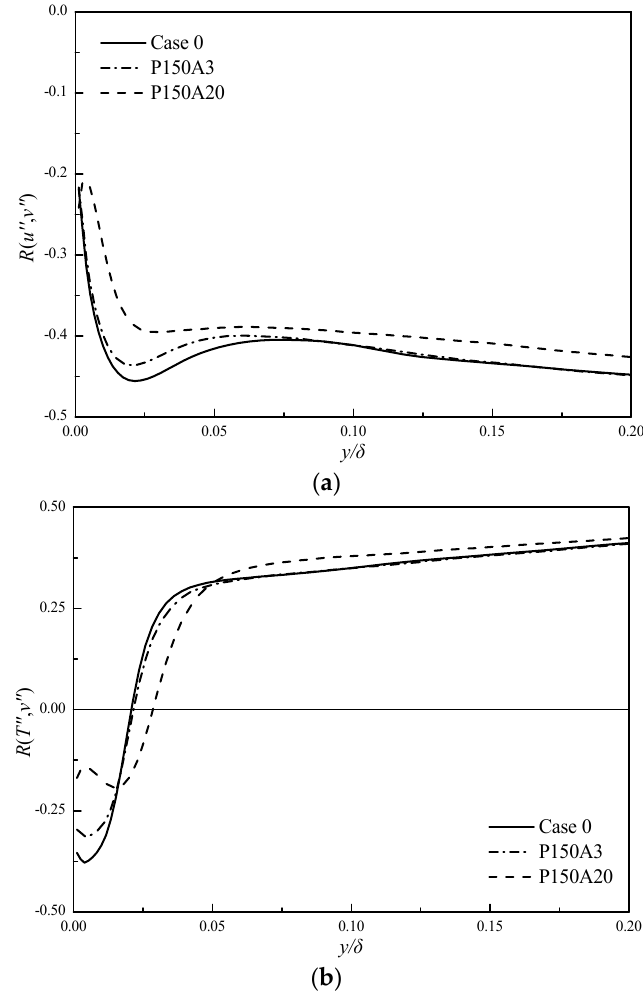
` ˘ u 2 , v 2 ( a ) and heat transport R